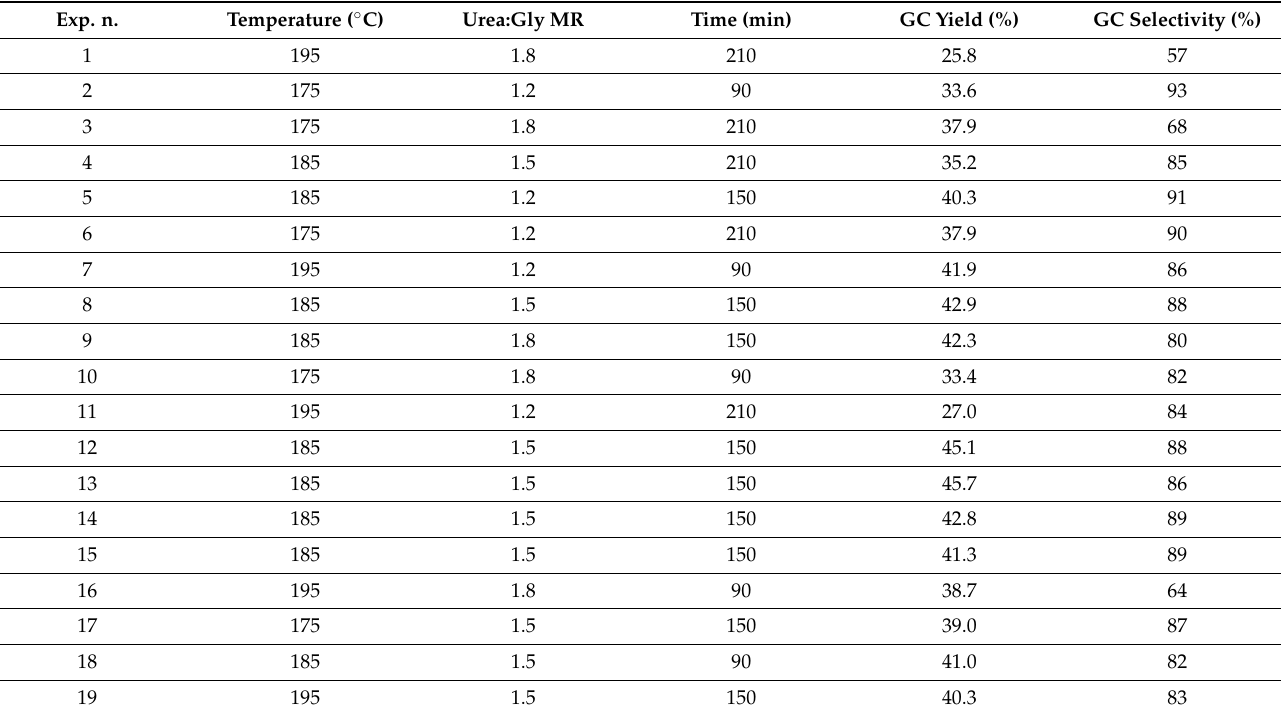
Table 2. Experiments suggested by the DoE model a